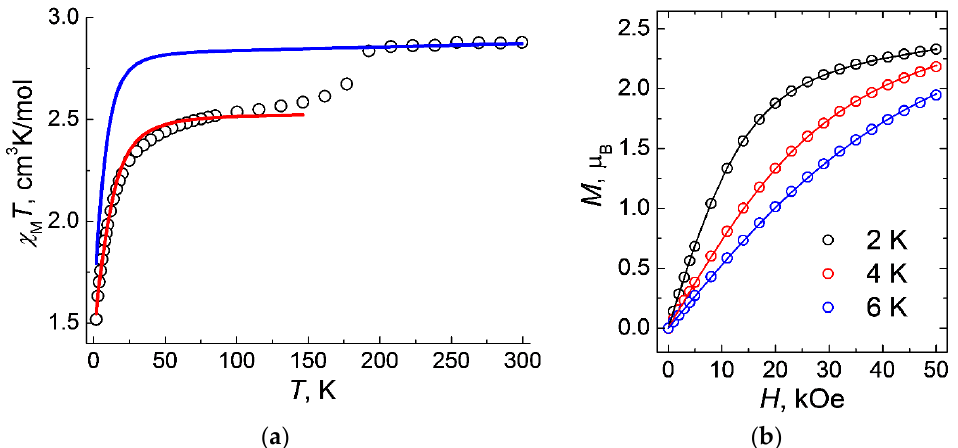
Figure 5. Temperature dependences of χ M T for 1 measured at H DC = 0.5 T ( a ) and magnetization vs. field measured at T = 2, 4, and 6 K ( b ). Theoretical curves (solid lines) are calculated at Hamiltonian (Equation (2); red line in Figure 5a) and Griffith Hamiltonian (Equation (1); blue line in Figure 5a)) and with the optimal set of parameters (see text).